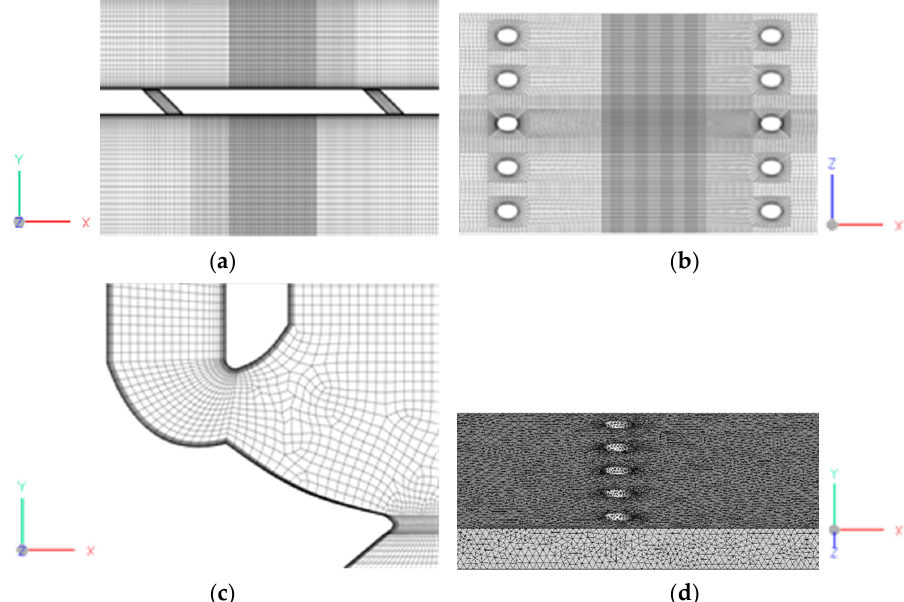
Figure 2. Local views of computation grids. ( a ) Mesh in periodic boundary, ( b ) Mesh on impinging surface, ( c ) Mesh of fluidic oscillator, ( d ) Mesh in solid domain.